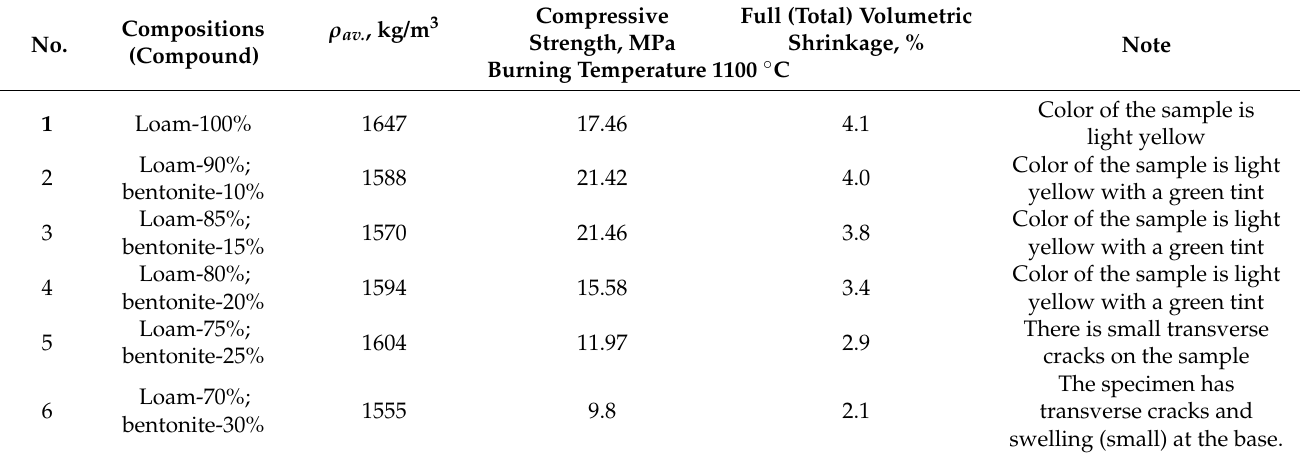
Table 4. Compositions of the charge and properties of products with the addition of bentonite